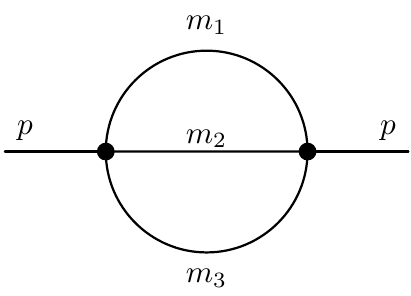
Figure 3 . The 2-loop 2-point function (sunset graph) with three di(cid:11)erent